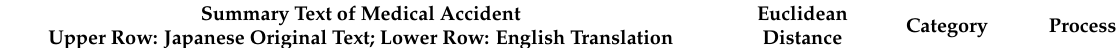
Table 5. An example results of a similar text search by the TRAINED SBERT with the UTH BERT model. The query is the same as in Table 4. The labels in red are those that match the labels in the